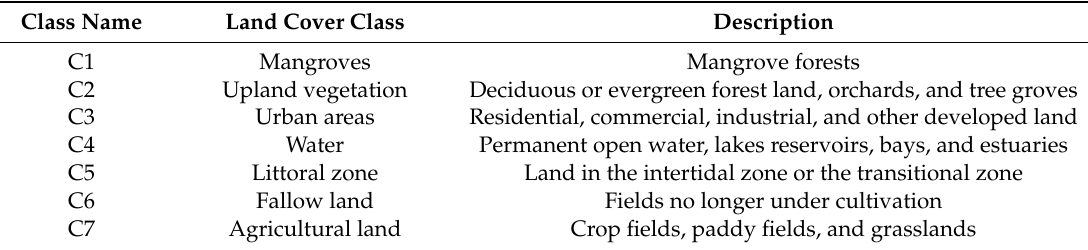
Table 3. Classification of land cover types.